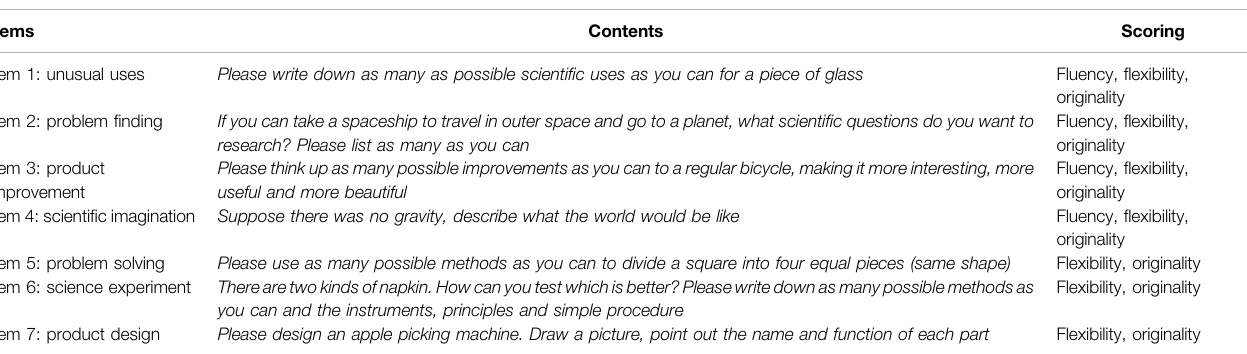
TABLE 1 | Scienti fi c creativity test (Hu and Adey, 2002; 2003; Huang and Wang,